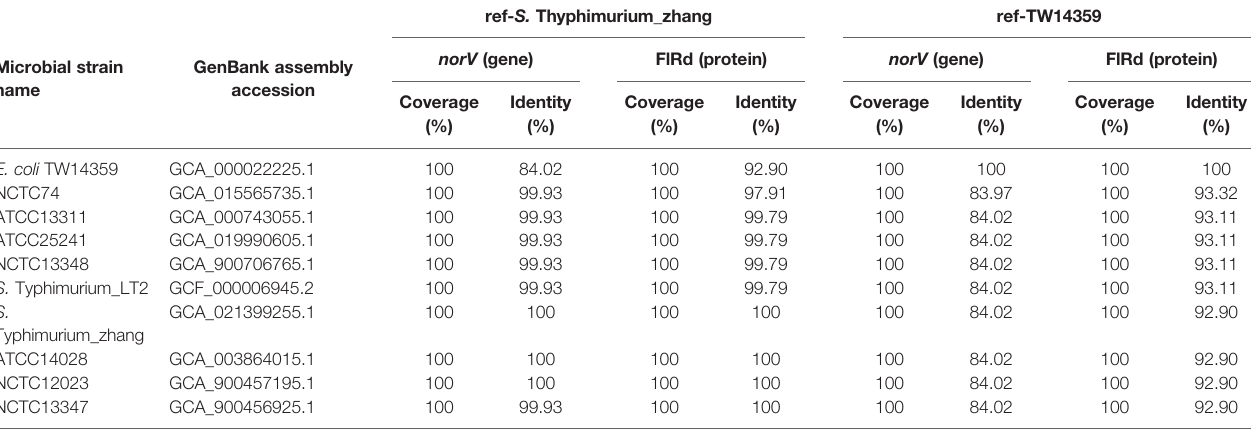
TABLE 1 | Identity of norV and encoded FlRd on S. Typhimurium_zhang, eight S. Typhimurium type strains and E. coli O157:H7 isolate TW14359 based on BLAST.